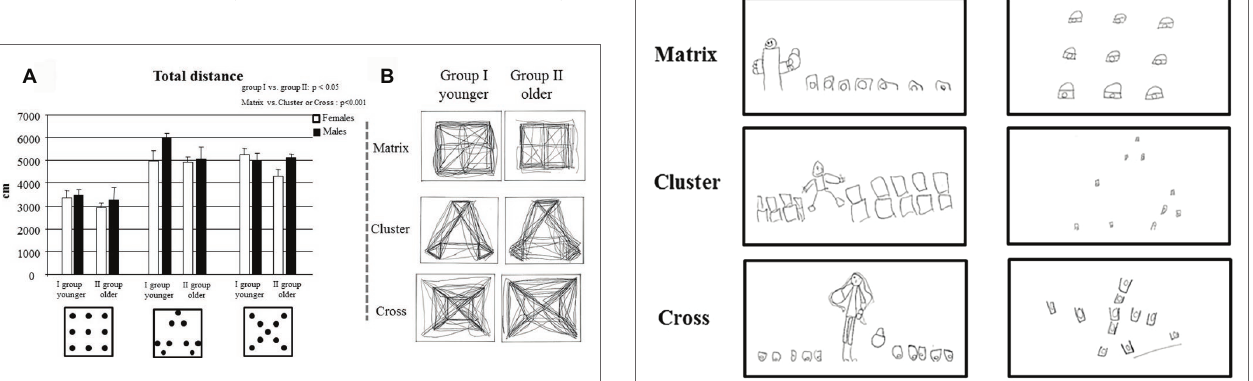
FIGURE 4 | Selected drawings of group I and group II. At the end of each configuration, the children were required to draw the setting they had just